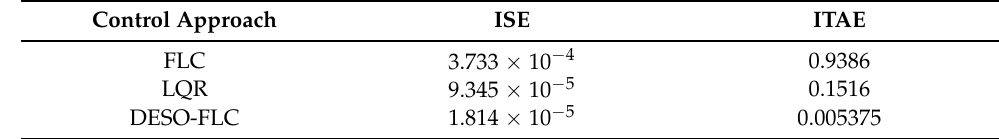
Table 4. Comparison of ISE and ITAE using various control approaches for case 2.